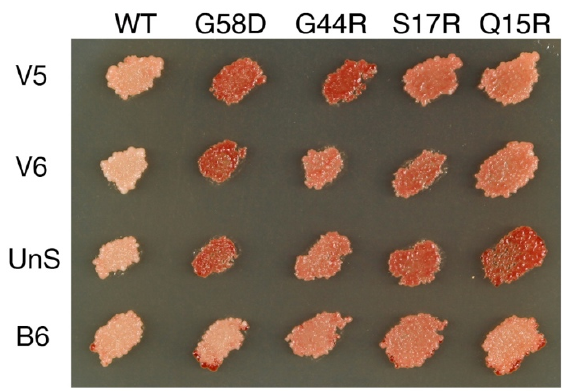
Figure 1. Transmutable [ PSI + ] variants stabilized in cells expressing Hsp104 T160M . Variants are propagated in cells expressing Hsp104 T160M and wild-type Sup35 from the chromosome. Different colony color patterns are observed when Sup35 single mutants (labeled on the top) are co-expressed from a plasmid. For V5, the color change is, from left to right, ( − , ++, ++, +, +). V6: ( − , ++, +, +, +); UnS: ( − , ++, +, ++, ++); B6: ( − , − , +, +, +). See Materials and Methods for an explanation of the variant typing method.